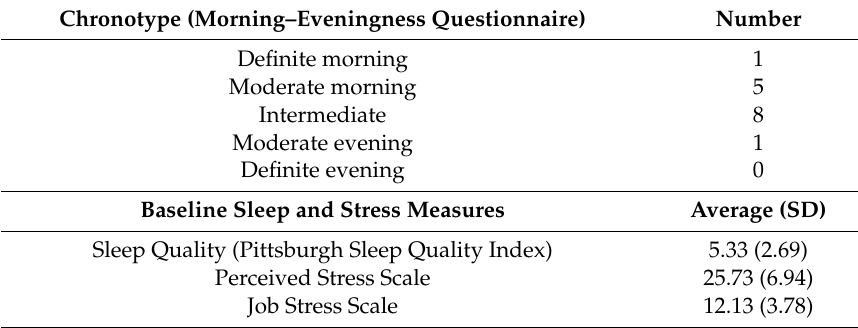
Table 2. Chronotype information of participants in this